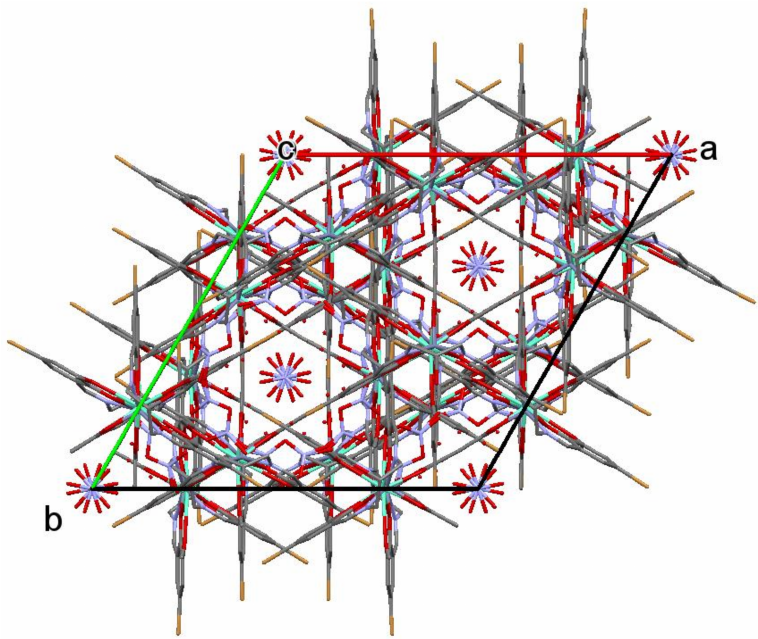
Figure 3. Crystal packing in 3 (Zn II –Eu III –Zn II )—view along the c axis.